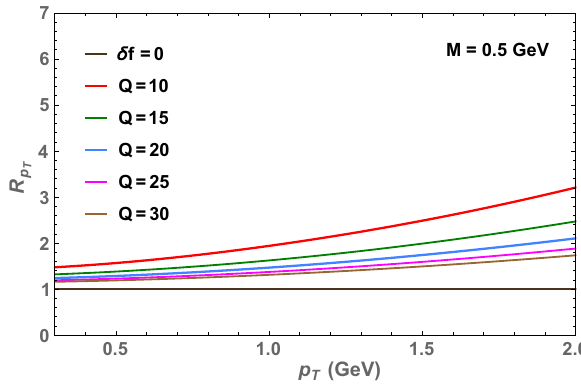
Fig. 2 Dilepton yields with non-equilibrium effects for different / T 3 ≡ Q values for M = 0 . 5 GeV. The equilibrium yield con- ˆ q q tribution is also plotted ( δ f = 0)